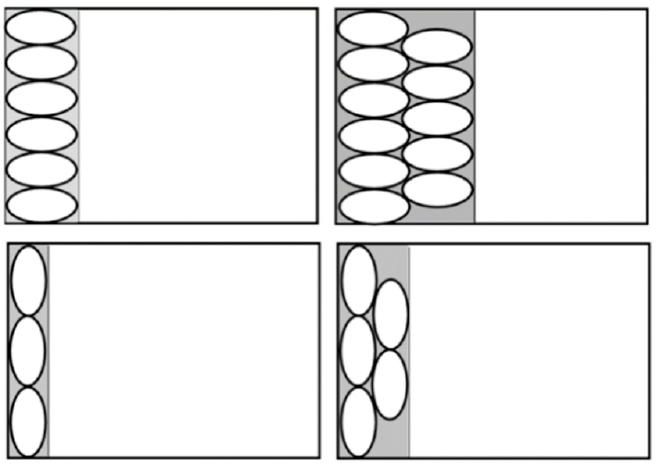
Figure 13. Examples of sections assuming arrow a is parallel to Y-axis.